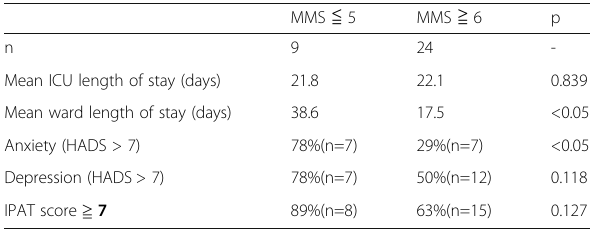
Table 1 (abstract 000892). Outcomes on ICU discharge with mobility as an independent variable